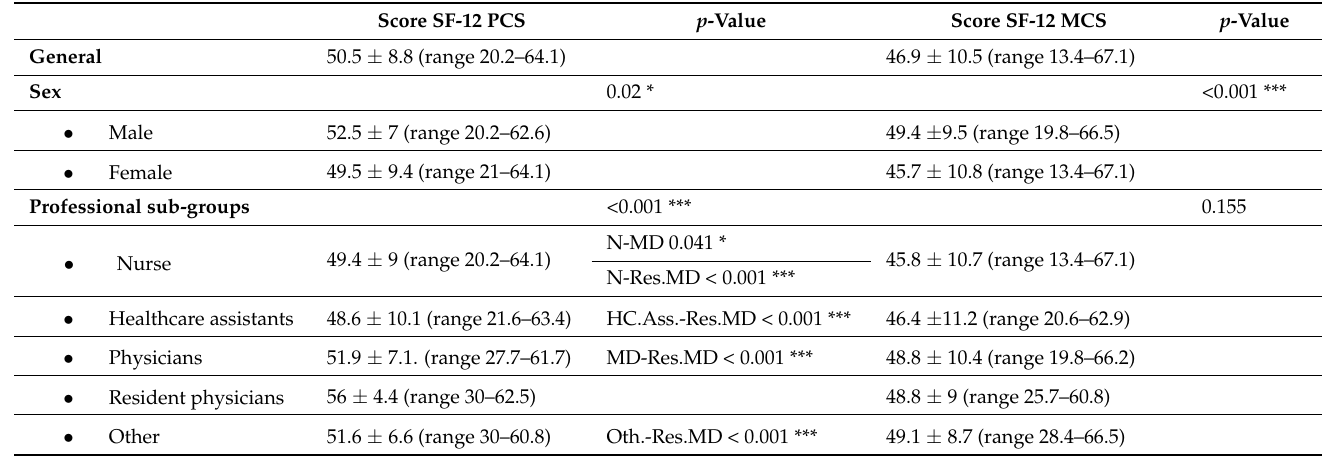
Table 5. Distribution of SF-12 PCS and MCS according to sex and professional